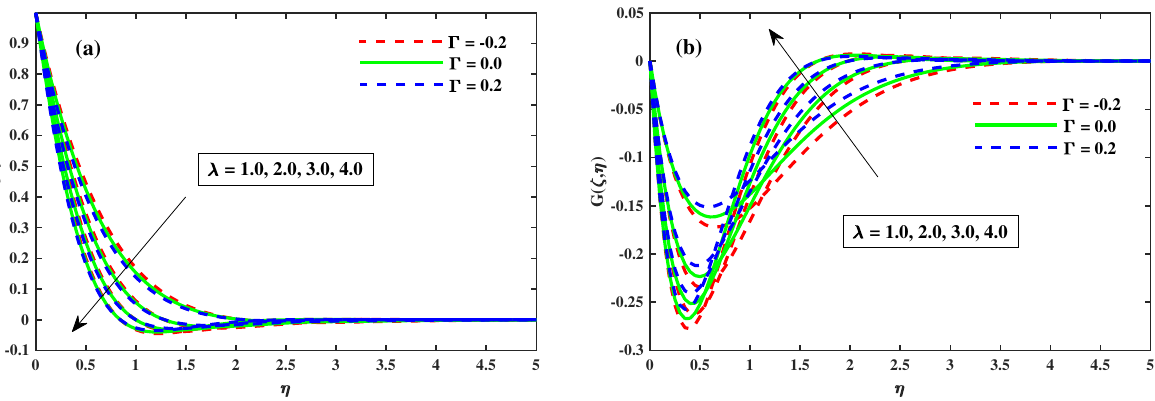
Figure 3. Influence of λ on G along y-direction in ( b ) and F (cid:48) along x-direction in ( a ) when ζ =